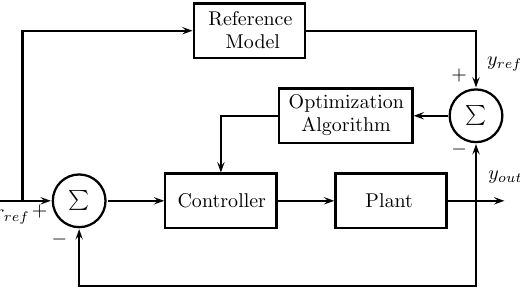
Figure 27. Scheme of the optimization process.